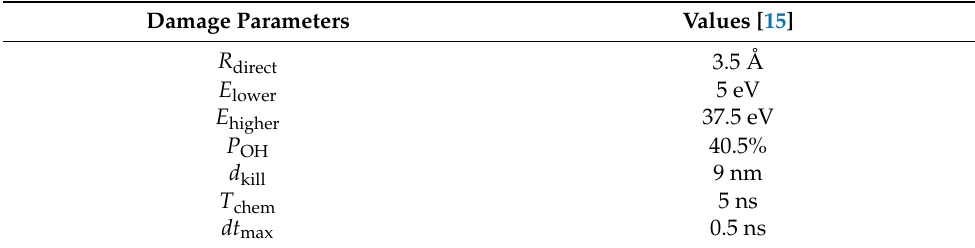
Table 1. The damage parameters used for predicting direct and indirect DNA damage induction. Damage